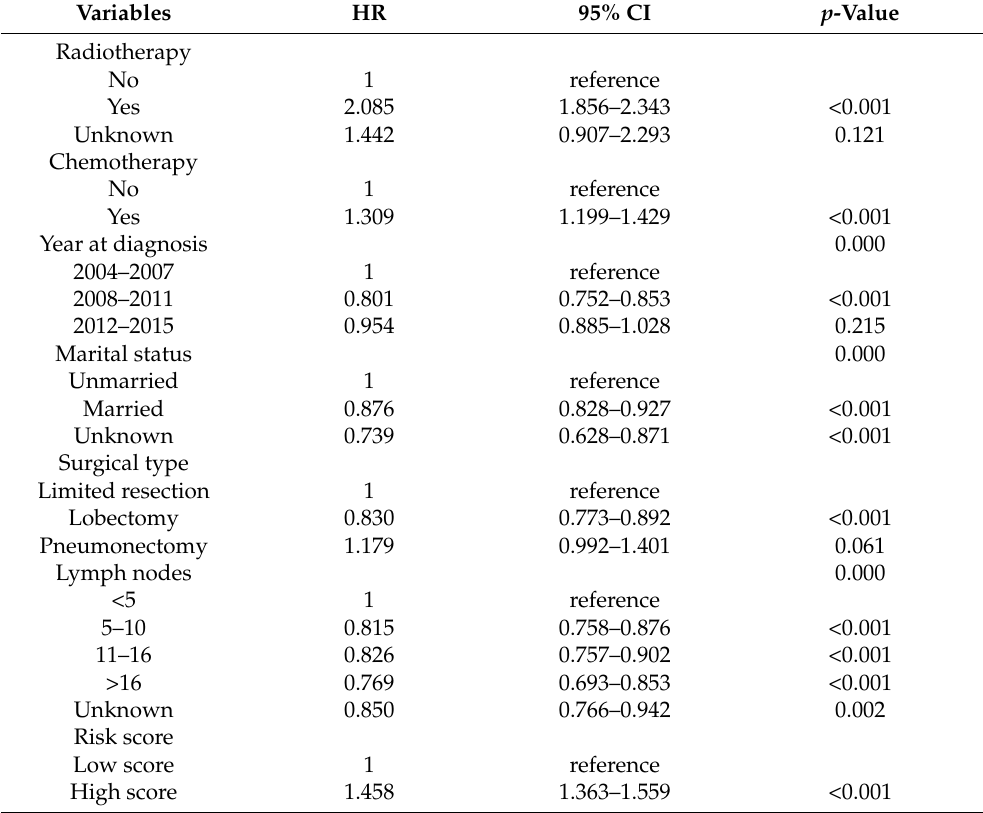
Figure 5. Stratified effect of the atelectasis/obstructive pneumonitis.